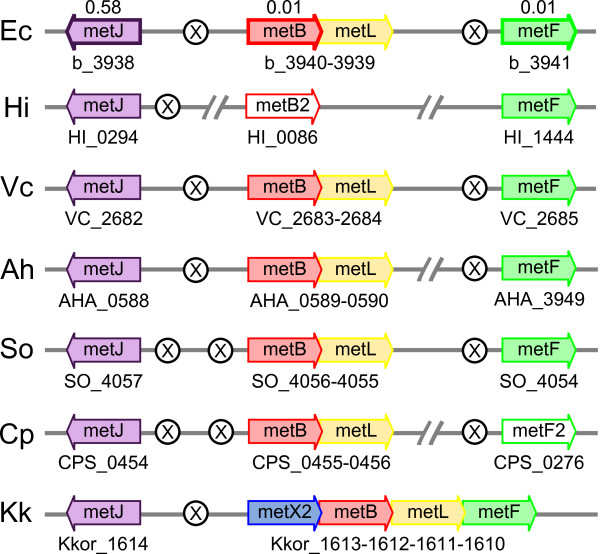
Genomic organization of the genes in the metJBLF cluster. Species are: Ec, Escherichia coli K12 MG1655 (Ent); Hi, Haemophilus influenzae Rd KW20 (Pas); Vc, Vibrio cholerae N16961 (Vib); Ah, Aeromonas hydrophila (Aer); So, Shewanella oneidensis (Alt); Cp, Colwellia psychrerythraea (Alt); and Kk, Kangiella koreensis (Alt). Genes are color-coded and spaces have been introduced between adjacent genes in order to align homologs vertically. In cases where a large number of other genes intervene between those of interest, a separation symbol is used://. Sites of metboxes are indicated by a circled X. Genes which were tested for repression in this paper are displayed with their repression ratio above the gene arrow.